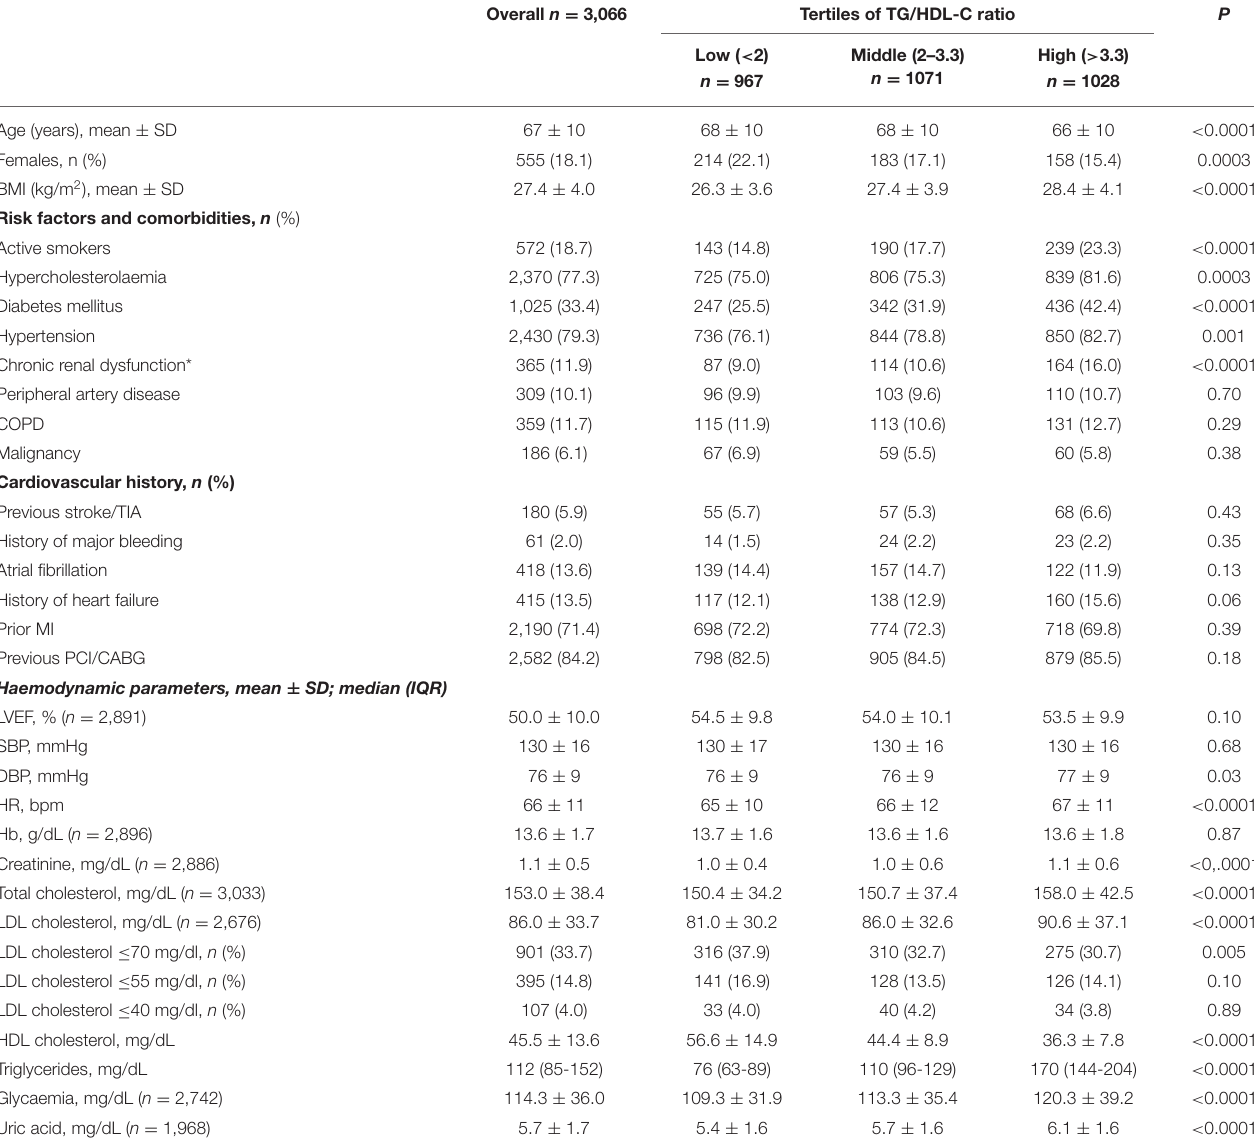
TABLE 1 | Baseline clinical characteristics of VHR patients with TG and HDL-C available.